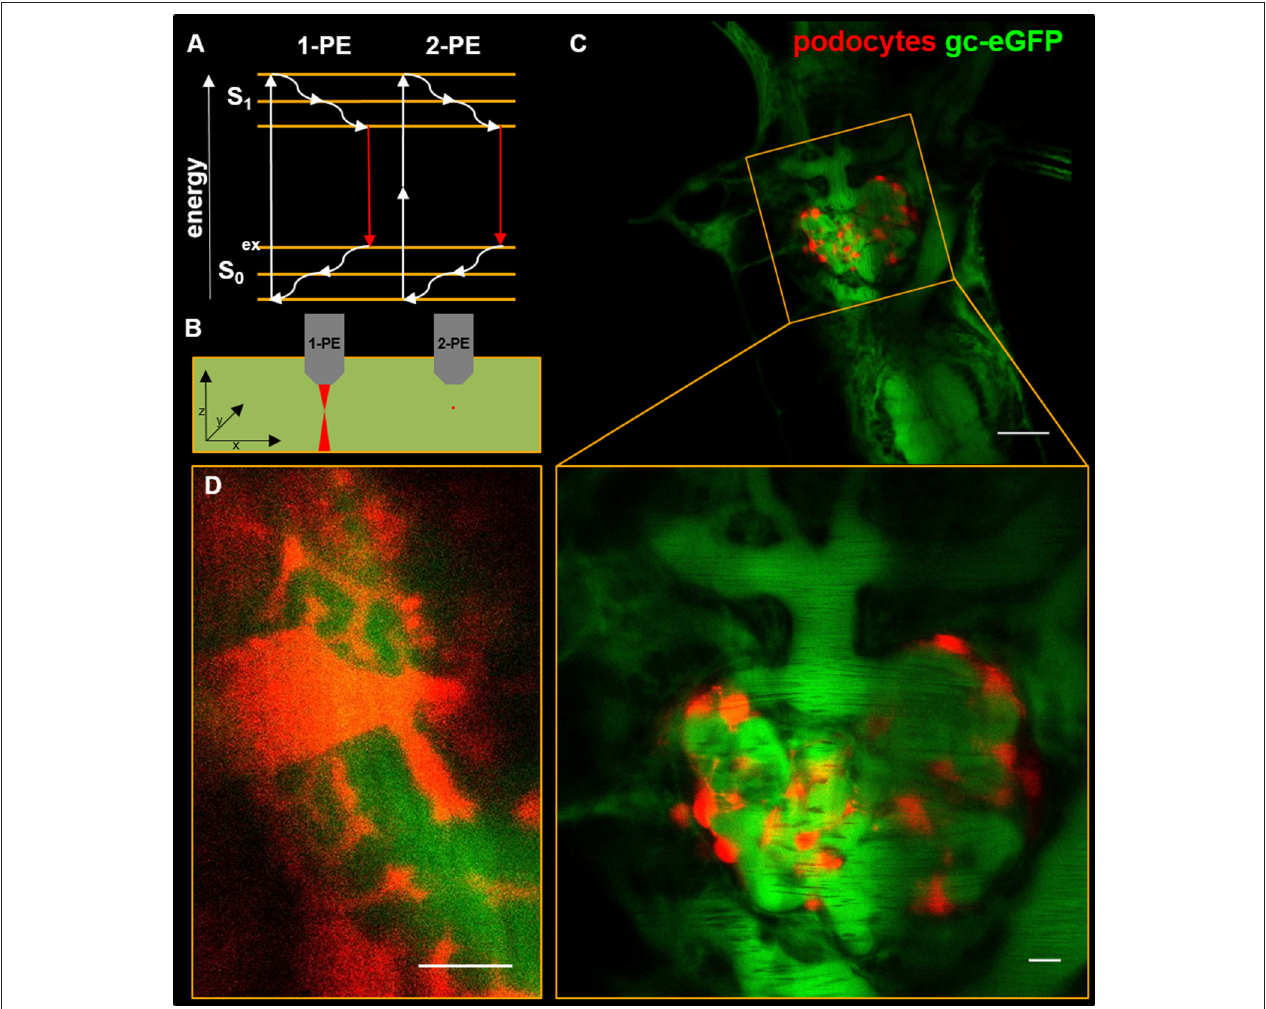
FIGURE 1 | The Jablonski diagram in (A) shows the energy levels of fluorophore electrons upon single-photon excitation (1-PE) and two-photon excitation (2-PE). For fluorescence emission, electrons are elevated from the S 0 to the S 1 level where they fall back to S 0 while emitting a photon. Dense temporal concentration of exciting photons of longer wavelengths compared with 1-PE elevates fluorophores up on the S 1 level with subsequent emission of a photon. (B) shows a scheme of 1-PE and 2-PE in a homogenously fluorescent liquid. Compared to 1-PE the fluorescence emission (red) of 2-PE excitation is spatially restricted to a small point within the focal plane. (C) shows an in vivo multiphoton micrograph of a transgenic zebrafish larva (5 days past fertilization) with expression of mCherry in podocytes and 78 kDa gc-eGFP fusion protein in the blood plasma. The magnification in (D) shows interdigitating major processes on the face of the glomerular capillaries. The scale bars indicate 50 µ m in (C) , 10 µ m in the magnification of (C) and 5 µ m in (D)